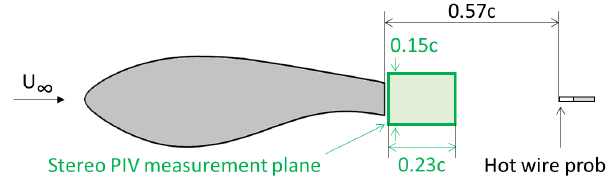
Figure 2. Schematic of the experimental set-up, showing the flat- back airfoil under investigation, LI30-FB10, the location of the hot- wire probe in the wake, and the size of the stereo PIV measurement